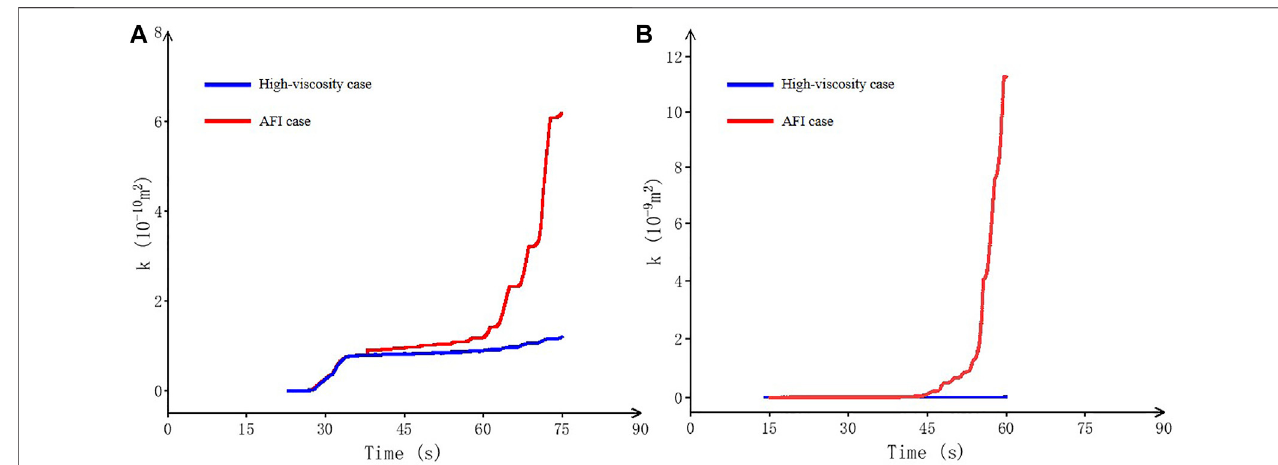
FIGURE 15 | NF permeability time history curve of the AFI and high-viscosity cases (A) NF dip angle is 45 ° ; (B) NF dip angle is 30 ° .